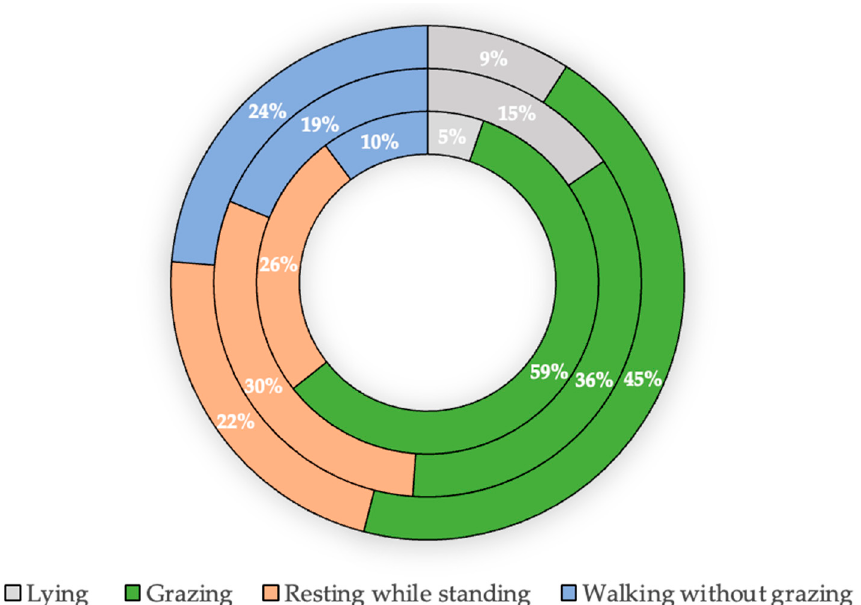
Figure 2. Seasonal importance of grazing activities of browsing experimental goats in the studied forest rangeland of Northern Morocco. From the inside to the outside in order of spring, summer, and